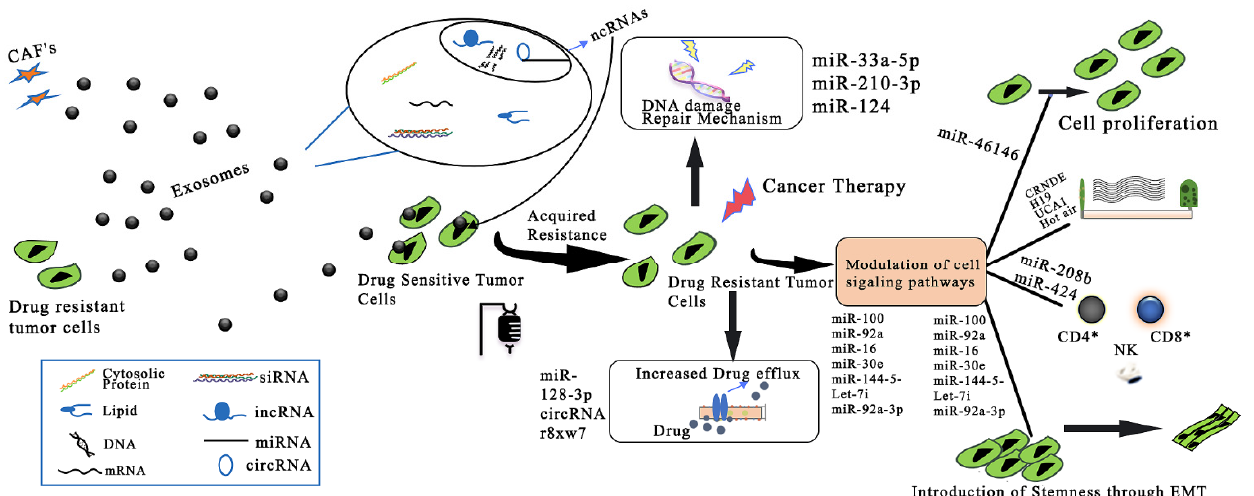
Figure 3. Exosomal ncRNA-related mechanisms implicated in CRC drug resistance. CAFs: cancer-associated fibroblasts; ncRNAs: noncoding RNAs; miRNA: microRNA; circRNA: circular RNA; lncRNA: long noncoding RNA. Adapted and modified from [75] under the Creative Commons li- cense.